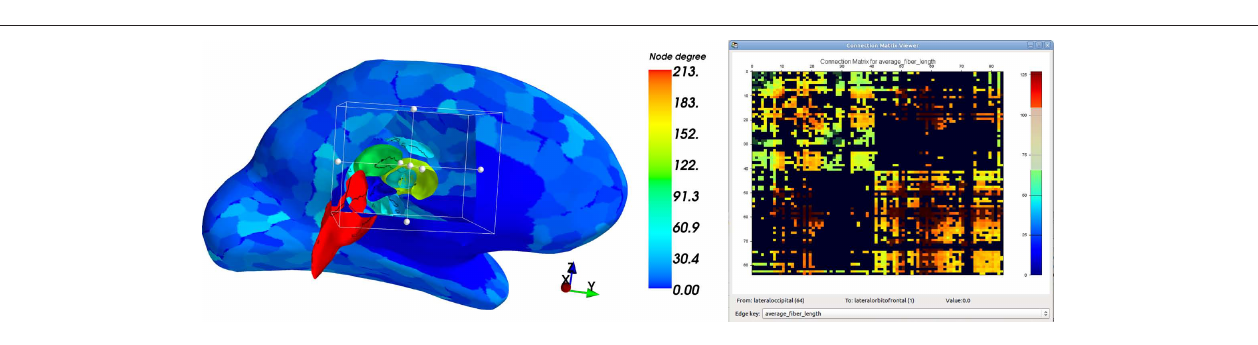
Figure 9 | Node degree display on the surface of an inflated left hemisphere (left). The right hemisphere and parts of the medial surface of the left hemisphere are clipped using the Mayavi DataSet Clipper. A set of left hemispheric cortical and subcortical regions is visible. The node degree of each region is coded in color. Blue corresponds to a low degree, green